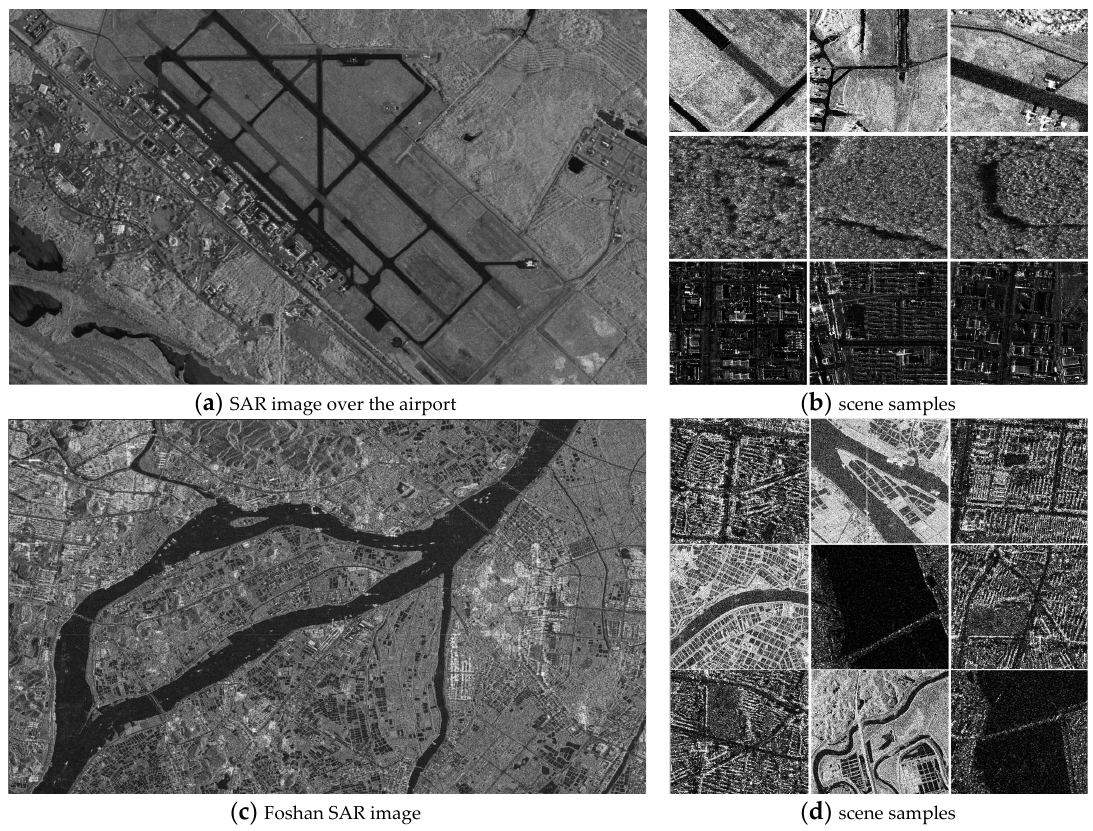
Figure 13. The SAR images and the samples acquired from the left SAR images.